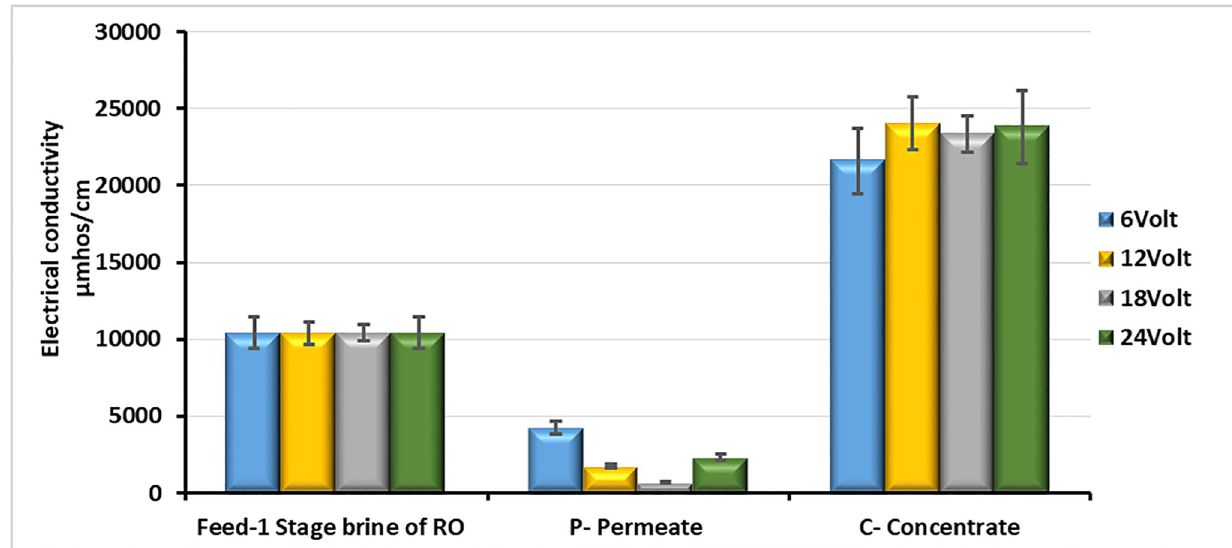
Fig 3. Comparison of the EC of the feed brine, the desalinated water, and the concentrated brine at 4 different voltages (feed flow rate = 12 L/h, water recovery ratio for TDS 6764 mg/L = 75% and feed temperature = 14˚C).